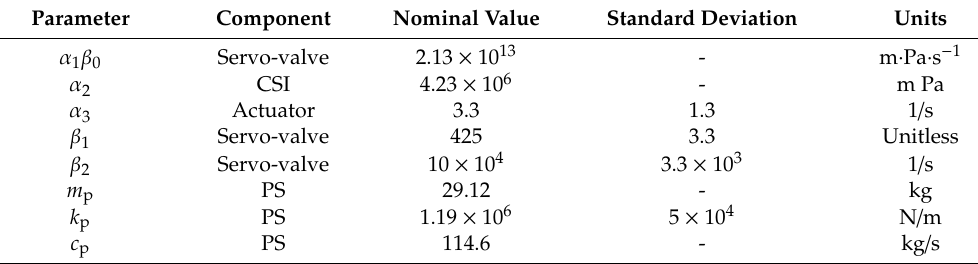
Table 2. Parametric values of the control